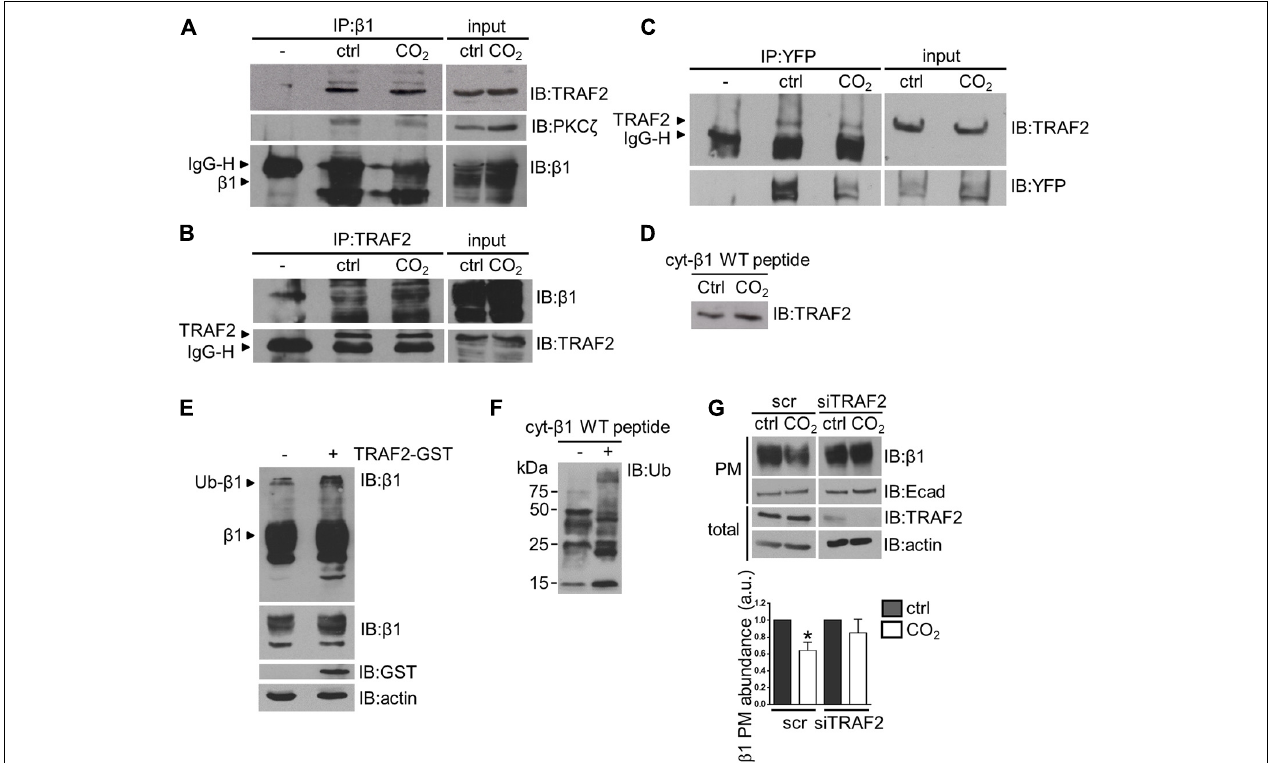
FIGURE 4 | TRAF2 mediates the hypercapnia-induced ubiquitination of the Na,K-ATPase β -subunit in alveolar epithelial cells. (A) A549 were exposed to 40 or 110 mmHg CO 2 at a pH of 7.4 for 10 min. Na,K-ATPase β -subunit was immunoprecipitated from total lysates with anti-Na,K-ATPase β 1-subunit monoclonal antibody and TRAF2 and PKC- ζ were detected with their respective antibodies by IB. Loading was controlled with an anti-Na,K-ATPase β 1-subunit monoclonal antibody. Representative western blots are shown. (B) A549 cells were exposed to 40 or 110 mmHg CO 2 at a pH of 7.4 for 10 min. TRAF2 was immunoprecipitated from total lysates with anti-TRAF2 polyclonal antibody and Na,K-ATPase β -subunit was detected with an anti-Na,K-ATPase β 1-subunit antibody by IB. Loading was controlled with an anti-TRAF2 monoclonal antibody. Representative western blots are shown. (C) A549- β 1-YFP cells were exposed to 40 or 110 mmHg CO 2 at a pH of 7.4 for 10 min. β 1-YFP protein was immunoprecipitated from total lysates with an anti-YFP monoclonal antibody and TRAF2 was detected with an anti-TRAF2 monoclonal antibody by IB. Loading was controlled with anti-YFP monoclonal antibody. (D) A549 cells were exposed to 40 or 110 mmHg CO 2 at a pH of 7.4 for 10 min. Total lysates were incubated with the biotinylated cyt- β 1 wt peptide overnight and streptavidin pull-downs were performed. TRAF2 was detected with anti-TRAF2 monoclonal antibody by IB. (E) Ubiquitinated Na,K-ATPase β -subunit forms were detected in total lysates from A549 cells transfected with TRAF2-GST construct or untransfected, by an anti-Na,K-ATPase β -subunit antibody. Overexposure of the x-ray films revealed Na,K-ATPase β -subunit polyubiquitinated forms. (F) TRAF2 IP from A549 cells was used to ubiquitinate cyt- β 1 wt peptide in an in vitro ubiquitination reaction. As a negative control the cyt- β 1 wt peptide was omitted. Biotinylated cyt- β 1 wt peptides were purified by streptavidin pull-downs and the Na,K-ATPase β -subunit ubiquitinated forms were detected with an anti-ubiquitin antibody by IB. (G) A549 cells were transfected with siRNA against TRAF2 or scrambled siRNA. 48 h after transfection, cells were exposed to 40 or 110 mmHg CO 2 at a pH of 7.4 for 30 min. Biotin-streptavidin pull-down of cell surface proteins was performed and Na,K-ATPase β -subunit abundance was analyzed by IB. Mean ± SEM, n = 3, paired t -test, * p <